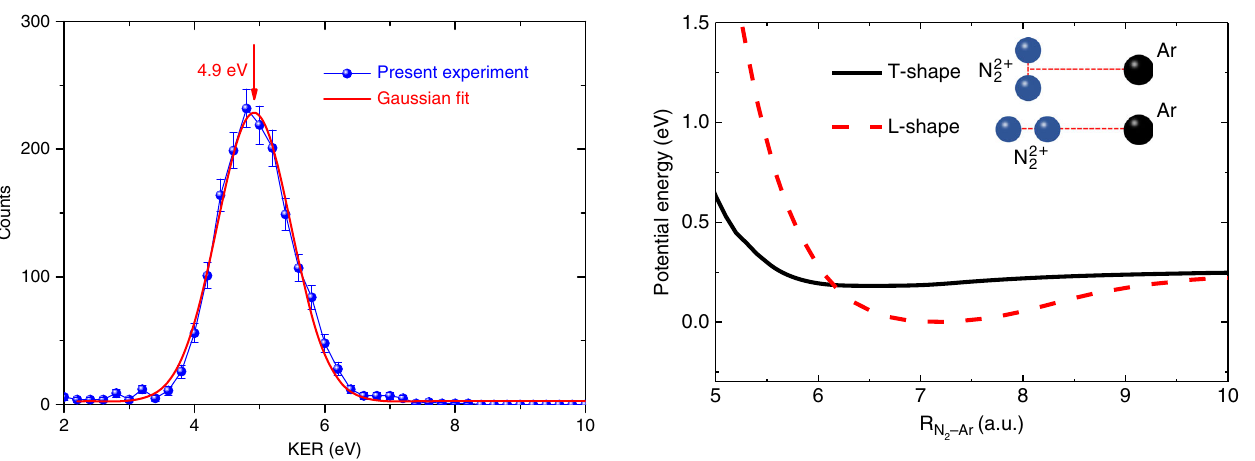
ions along 2 Ar